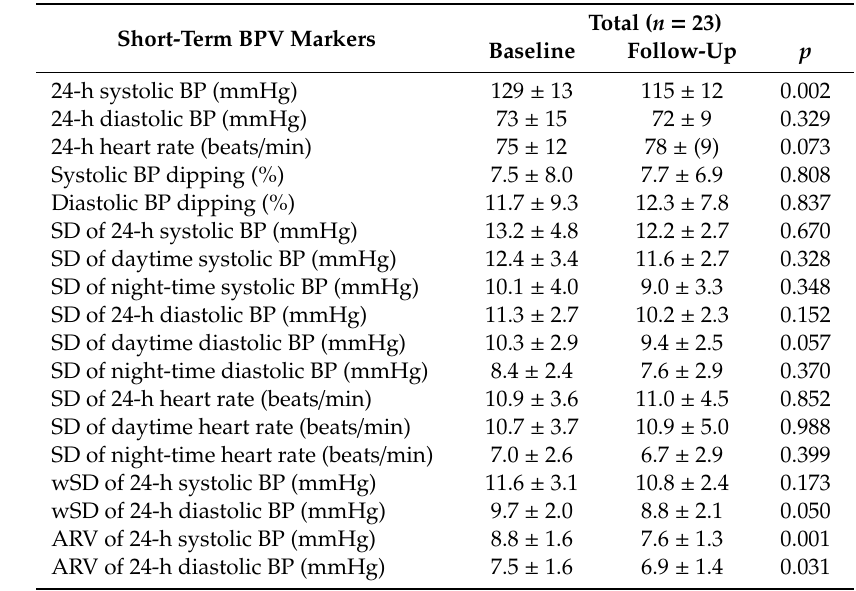
Table 3. 24-h ABPM-derived short-term blood pressure variability (BPV) markers at baseline compared to follow-up after surgical